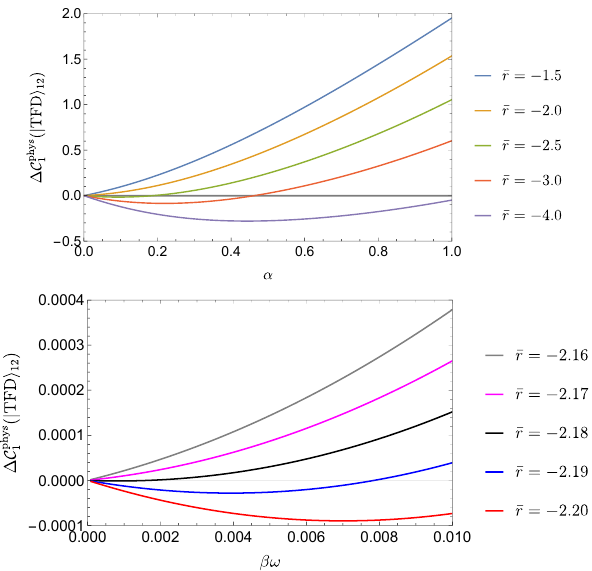
Figure 13 . The mutual complexity (cid:1) C phys 1 ln ! < 0 as a function of (cid:11) . We (cid:12)nd that the quantity (cid:1) C phys 2 (cid:22)